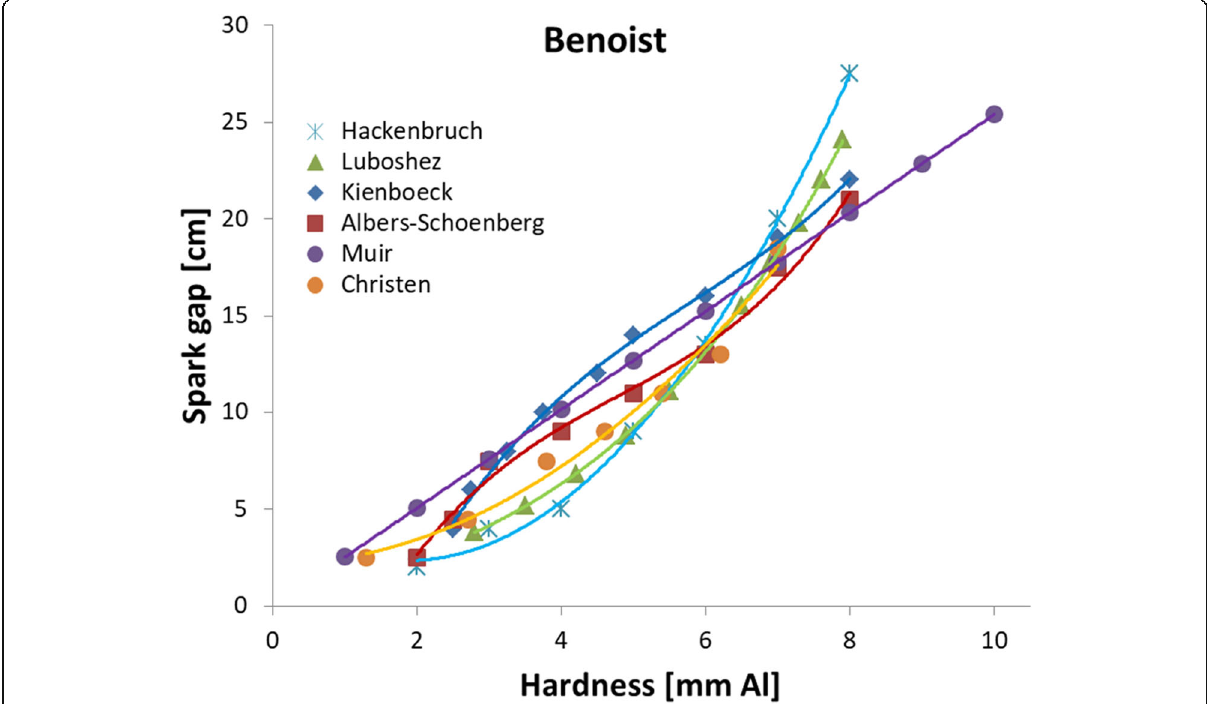
Fig. 3 Spark gap length as a function of the Benoist hardness. Most often the letter B was used, only followed by a number, thus without the unit “ mm Al ” [17 – 22]